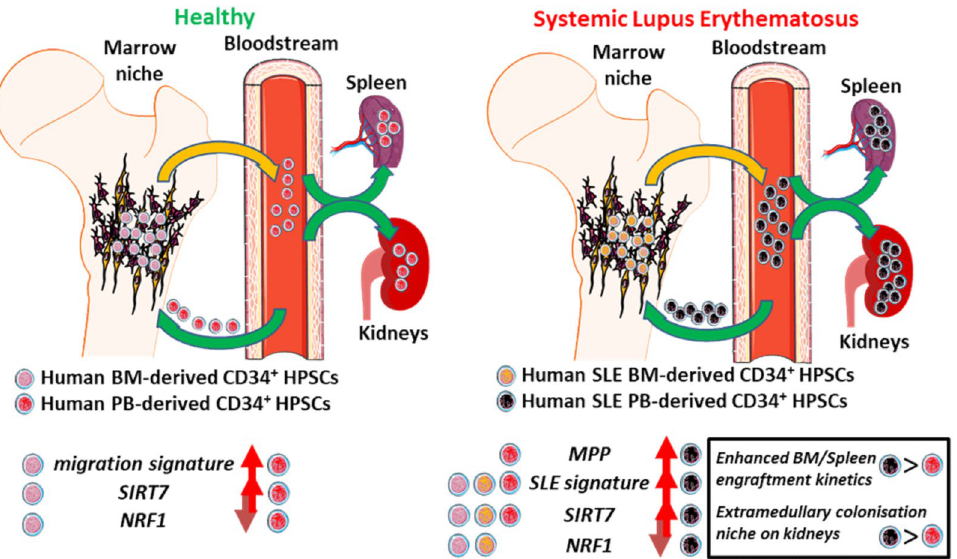
Figure 7. Schematic representation of the kinetics of PB- and BM-derived human CD34 + progenitors from healthy and SLE individuals, in relation to NRF1 and SIRT7 DEG as well as their extramedullary potential based on RNA-seq and comparison of SLE and Healthy PB xenotransplantation potential in humanised